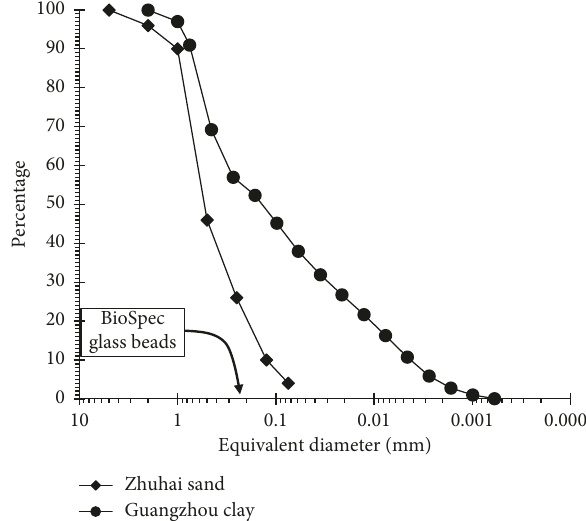
Figure 2: Grain size distribution of the studied